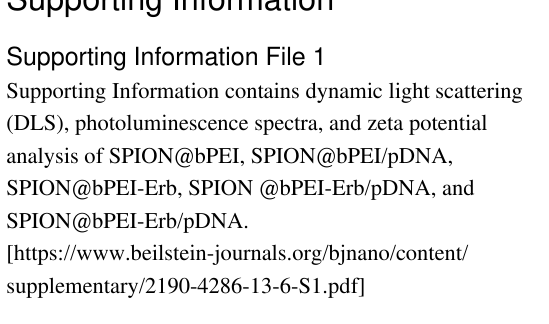
golden standard for non-viral gene transfection with an added advantage of strong luminescence in this unique SPION@bPEI structure, holds great potential for effective gene/drug delivery coupled with dual-mode